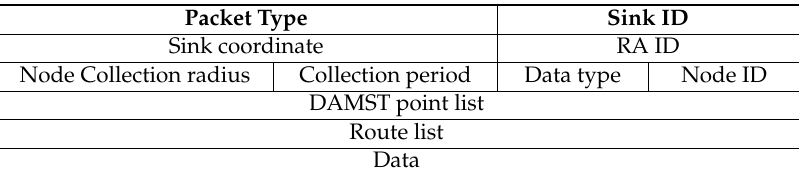
Table 2. Definition of notations.